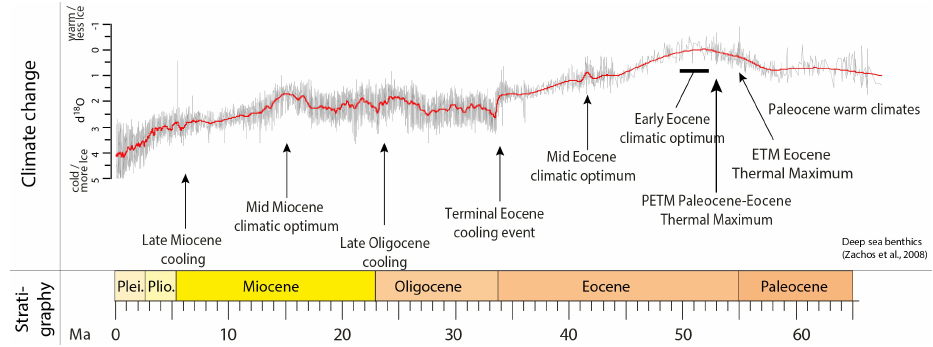
Figure 1. The main Cenozoic global climate events along the deep sea benthic isotope record (Zachos et al.,